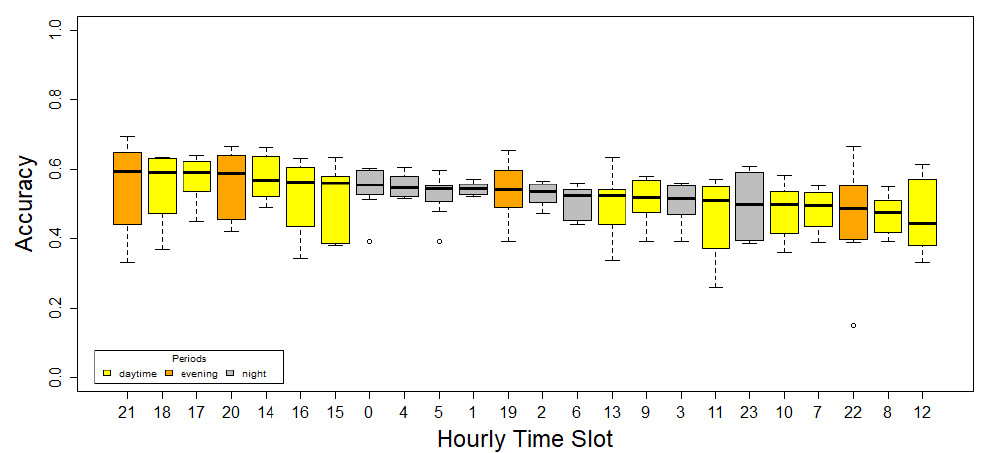
Figure 3. Statistical distributions of the Accuracy variable for each hourly time slot, represented though box and whisker plot and sorted by the median value of the Accuracy in decreasing order.